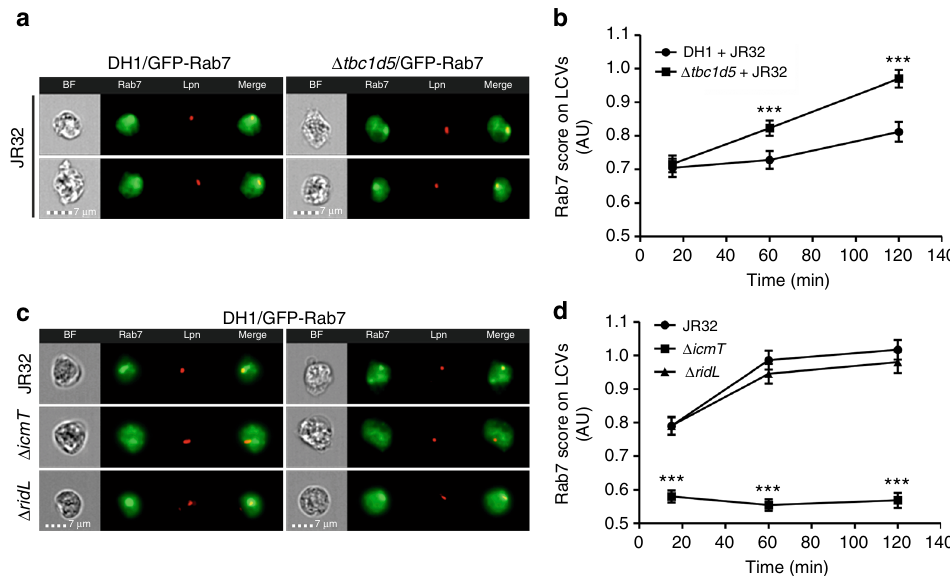
Fig. 7 D. discoideum TBC1D5 reduces Rab7 on LCVs. a Imaging fl ow cytometry (IFC) images of D. discoideum DH1 (WT or Δ tbc1d5 ) producing GFP-Rab7 (pAW9), infected (MOI 5, 2 h) with mPlum-producing L. pneumophila JR32 (pAW14). b Quanti fi cation of IFC co-localization score between GFP and mPlum in > 750 cells per sample at the time points p.i. indicated. The data show mean and 95% con fi dence intervals of one representative experiment out of four independent experiments (*** P < 0.001; two-way ANOVA with Bonferroni post hoc test). c IFC images of D. discoideum DH1 producing GFP-Rab7 (pAW9), infected (MOI 5, 2 h) with DsRed-producing L. pneumophila JR32, Δ icmT or Δ ridL harboring pCR77. d Quanti fi cation of IFC co-localization score between GFP and DsRed in > 1000 cells per sample at the time points p.i. indicated. The data show mean and 95% con fi dence intervals of one representative experiment out of four independent experiments (*** P < 0.001; two-way ANOVA with Bonferroni post hoc